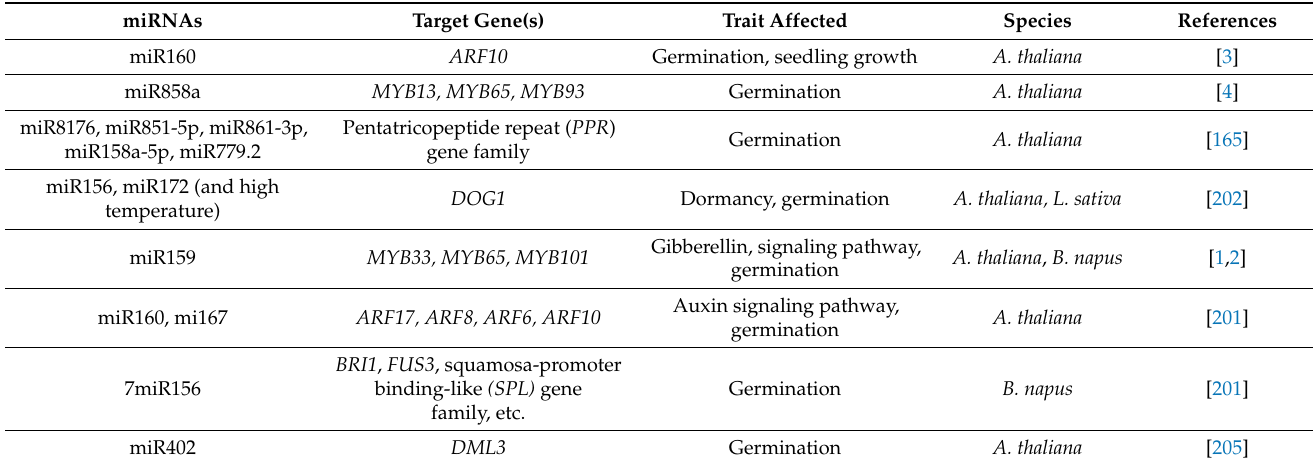
predicted targets of miR858a (MYB13, MYB65, and MYB93) are known as the regulators of germination, this RNA might also be involved in germination [165]. Table 2. The list of miRNAs involved in regulation of seed development and germination.